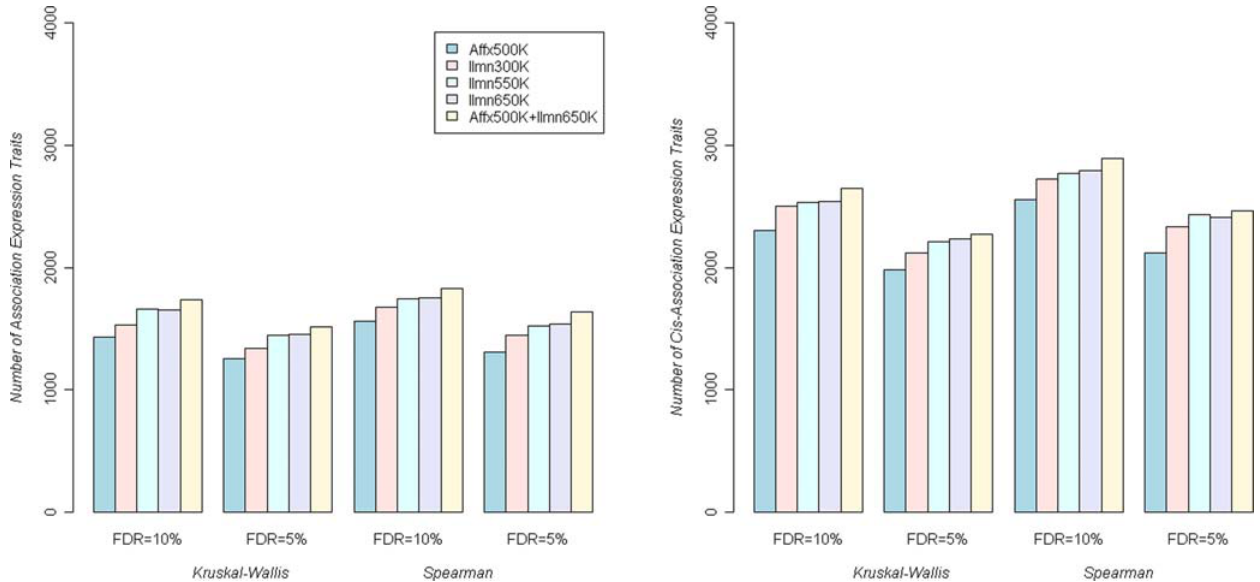
Figure 4. Tests of association on liver gene expression traits. (A) Number of gene expression traits that were associated with SNPs on Affymetrix and Illumina microarrays at fixed FDR levels. (B) We restricted the association tests to SNPs within 1 Mb range of the gene and present the number of cis -associating gene expression traits at a given FDR level.